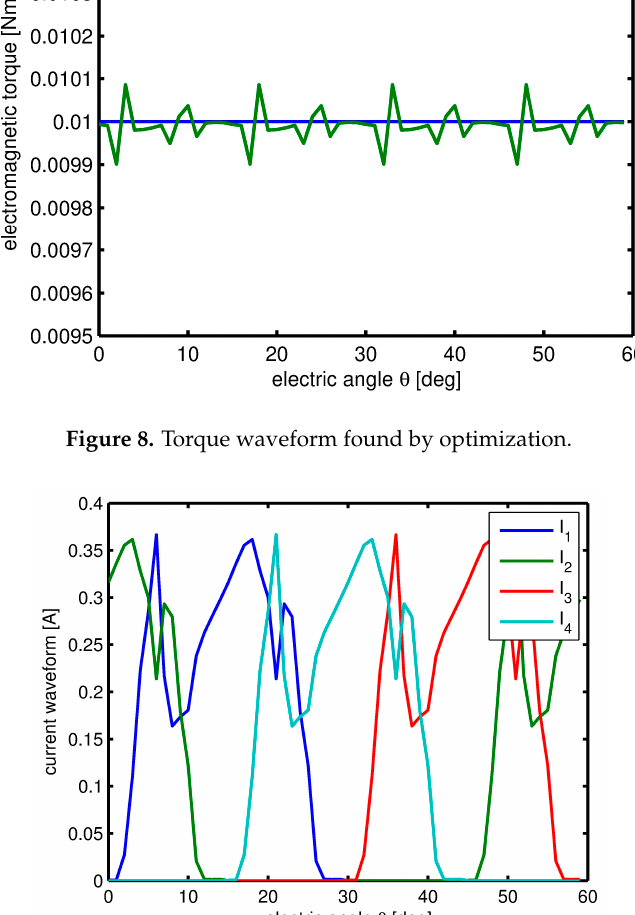
Figure 9. Current waveform found by optimization with weights: γ e = 1.0, γ u = 0.1, and γ s = 0.1 .